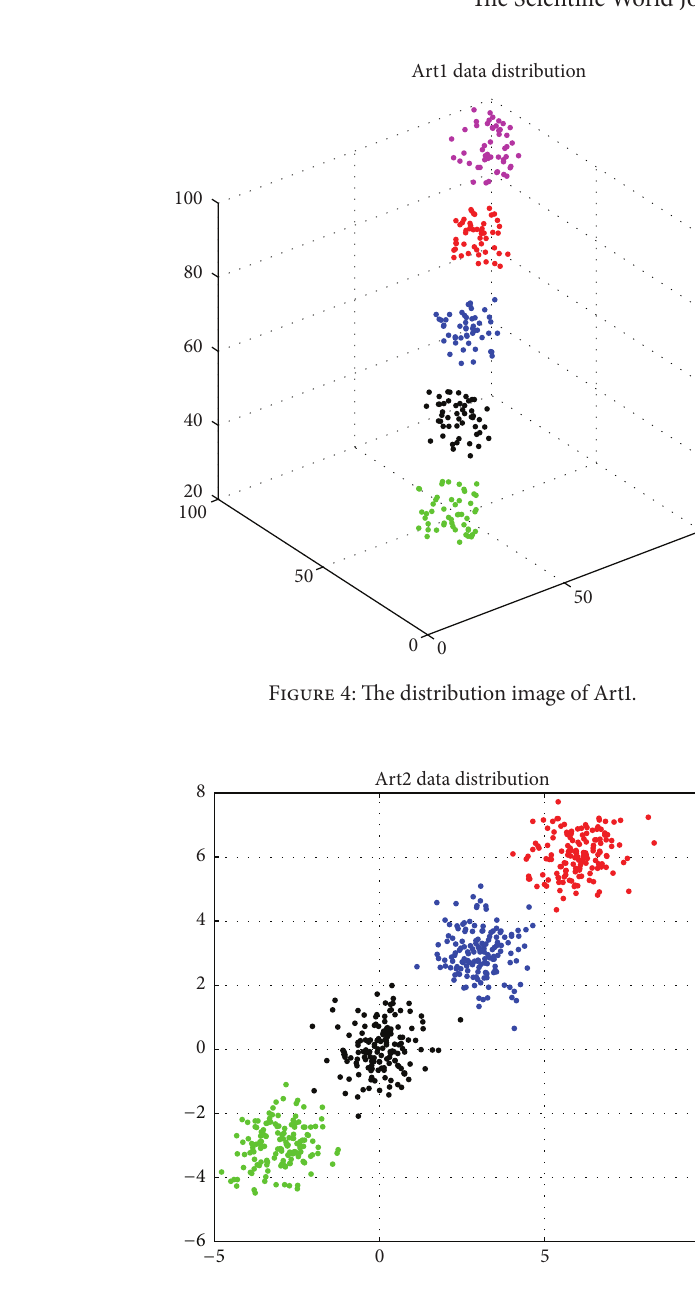
Figure 5: The distribution image of